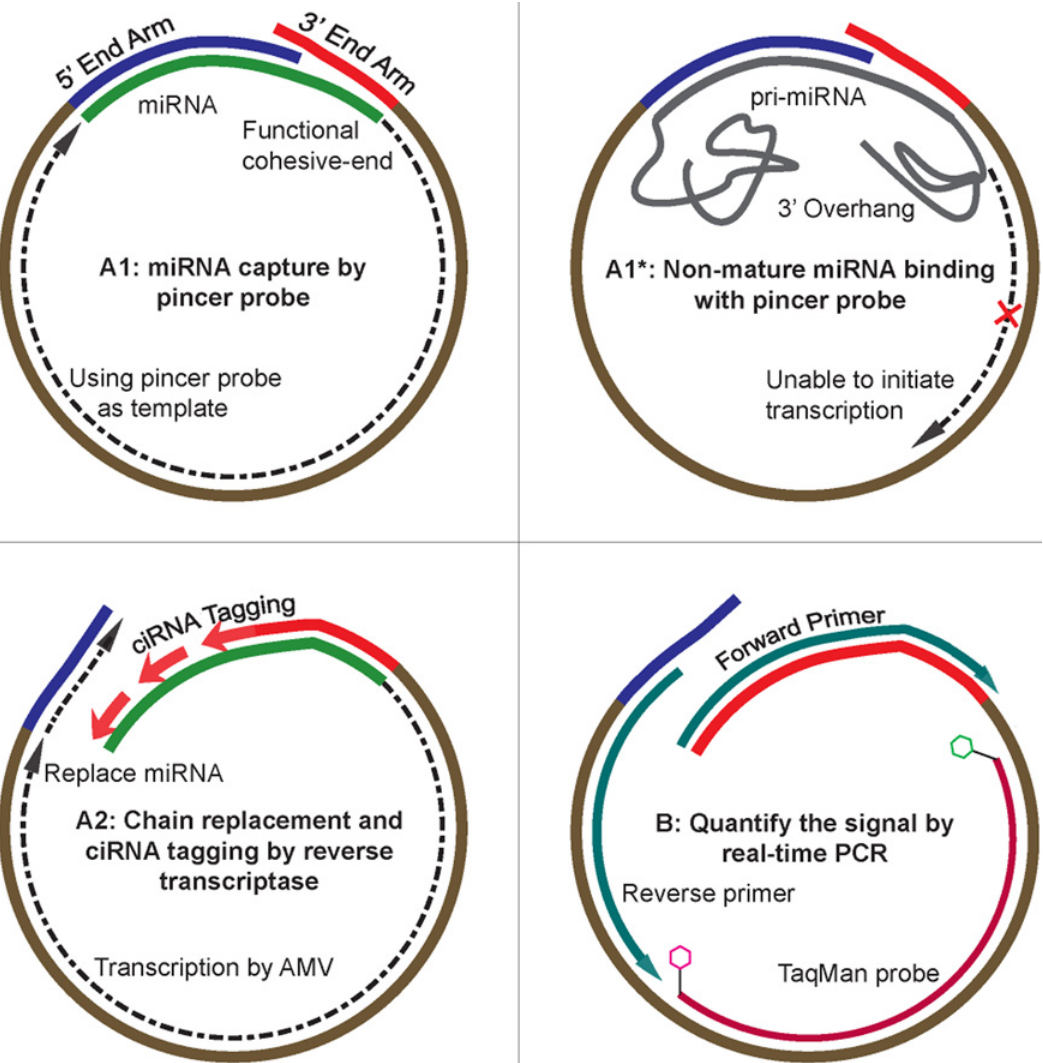
Fig 1. Schematic of the pincer probe-based miRNA quantification system. The pincer probe-based miRNA quantification assay included two steps: A) pincer probe reverse transcription and B) TaqMan real-time PCR. First, the pincer probe captured the target miRNA by undergoing a “ pincer-like movement ” and initiated transcription using the miRNA as a primer and the pincer probe as a template (A1). Although they can bind to the pincer probe, the nonmature miRNAs cannot initiate reverse transcription because of the 3 0 end overhang (A1 * ). Then, the reverse transcriptase displaced the miRNA sequence complementary to the 5 0 arm of the pincer probe that was encountered during synthesis and added a ciRNA tag to the 3 0 end of the pincer probe (A2). Finally, the ciRNA-tagged pincer probes were quantified using conventional TaqMan qPCR assays that include the ciRNA-specific forward primer, the reverse primer, and dye-labeled TaqMan probes